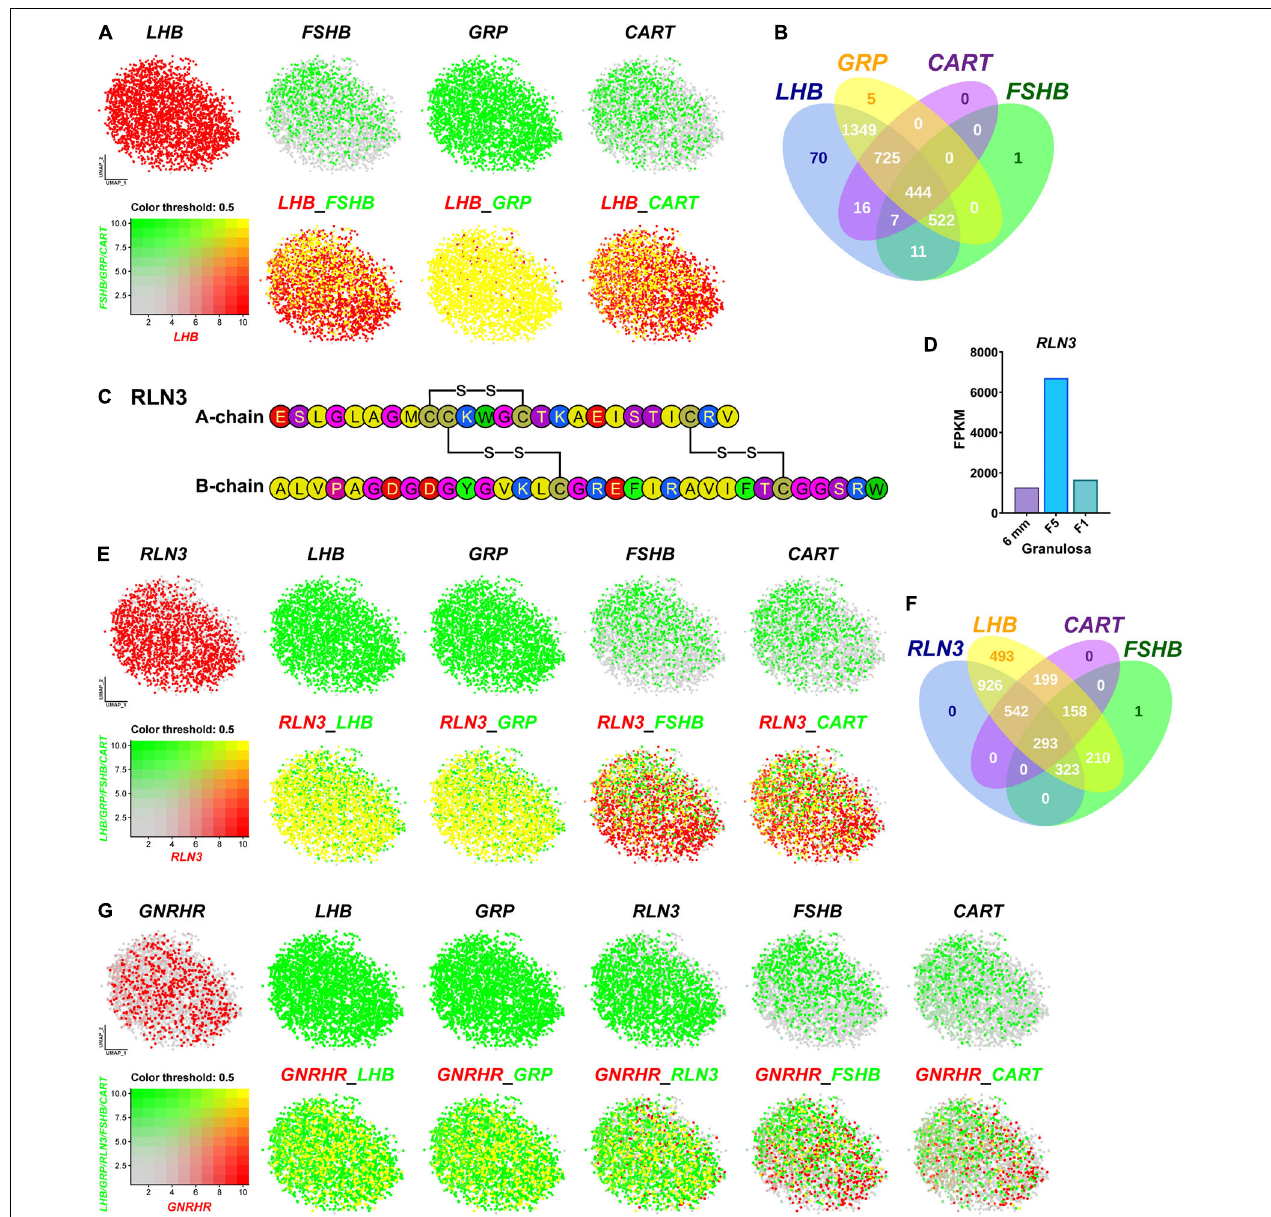
FIGURE 5 | Visualization of the genes co-expressed in gonadotrophs. (A) Co-expression of LHB and other hormone gene ( FSHB / GRP / CART ) in gonadotrophs. Gene expression levels are color coded. Red/Green indicates the high expression level and gray indicates the low expression level, as shown in the bottom left corner. Cells abundantly co-expressing LHB and FSHB / GRP / CART are shown in yellow. (B) Venn diagram showing the numbers of LHB , GRP , CART and FSHB -positive cells in Gona-cluster. (C) Amino acid sequence of the A- and B-chains of chicken RLN3 (accession no.: MT263682). The three disulfide bonds formed by six cysteine residues (red) are highlighted by red lines. (D) RNA-Seq analysis showing the abundant expression of RLN3 in granulosa cells of growing follicles (6 mm, F5, F1) in adult chicken ovaries. The expression levels of the RLN3 transcripts were expressed in FPKM values. (E) Co-expression of RLN3 with LHB / GRP / FSHB / CART in gonadotrophs. (F) Venn diagram showing the numbers of RLN3- , LHB- , CART- , and FSHB -positive cells in the gonadotroph cluster. (G) Co-expression of GNRHR (also called GnRHR2 in birds) and LHB / GRP / RLN3 / FSHB / CART in